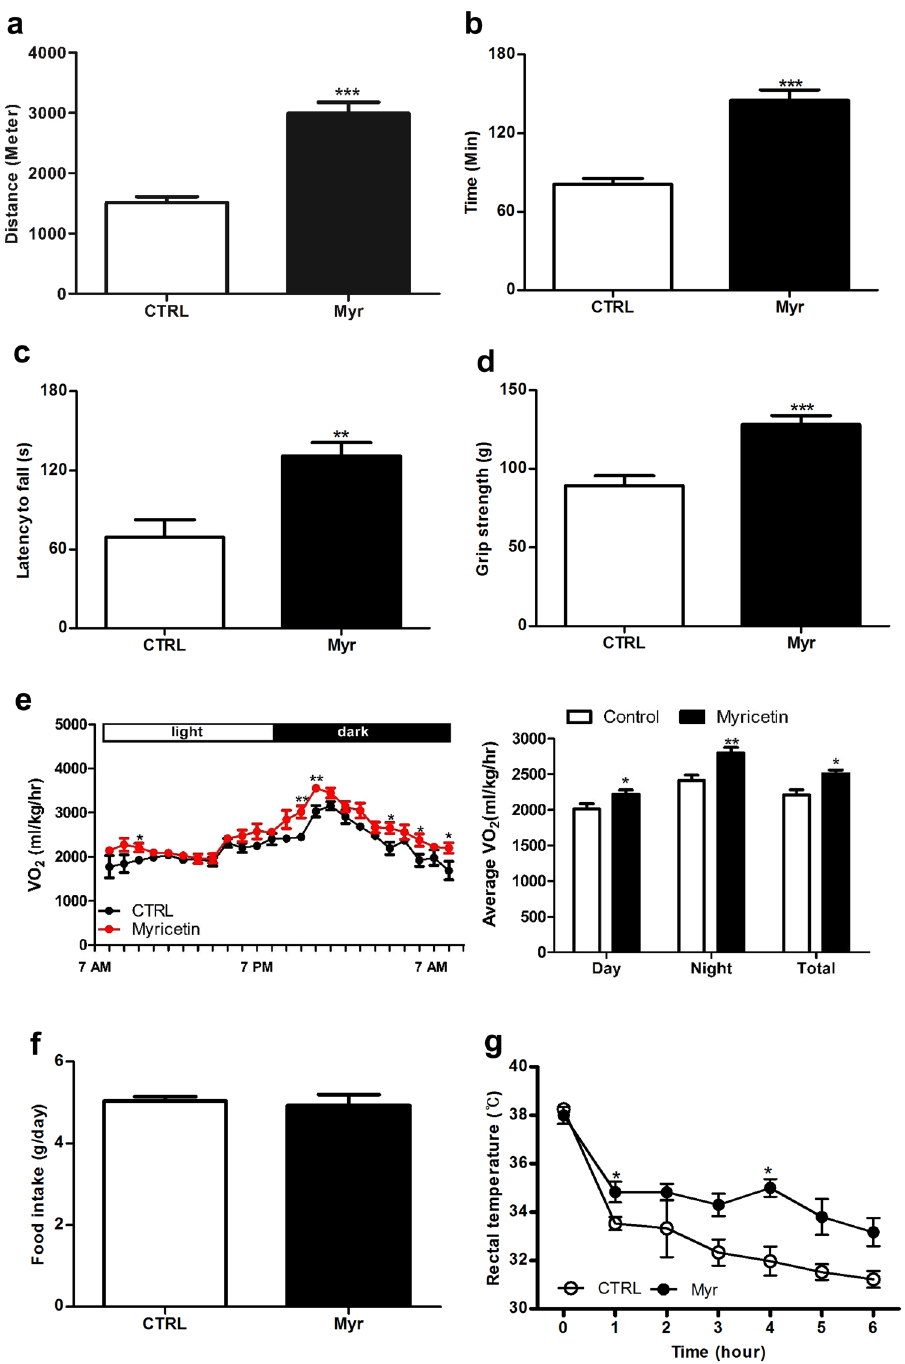
Figure 1. Myricetin improved motor function and energy expenditure (EE). ( a , b ) The effect of myricetin on endurance, as measured by a treadmill exercise test. The average run-until-exhaustion distance ( a ) and time ( b ) are presented for animals treated with PBS or myricetin at 50 mg/kg (n = 10 animals/group). ( c , d ) Behavior tests to evaluate mouse sensorimotor function using a rotarod ( c ), and grip strength test ( d ) (n = 10 animals/group). ( e ) EE as measured by changes in O 2 consumption in indirect calorimetry over 24 hr. Average VO 2 during light and dark cycles in mice administered myricetin or not are shown in the graph on the right (n = 6~8 animals/ group). ( f ) Myricetin treated mice showed no effect on food intake of mice. ( g ) The internal body temperature during a cold tolerance test (4 °C for 6 hr). n = 4 animals/group. Unpaired Student’s t-tests, * = P < 0.05, ** = P < 0.005, *** = P < 0.0005. Values represent means ±